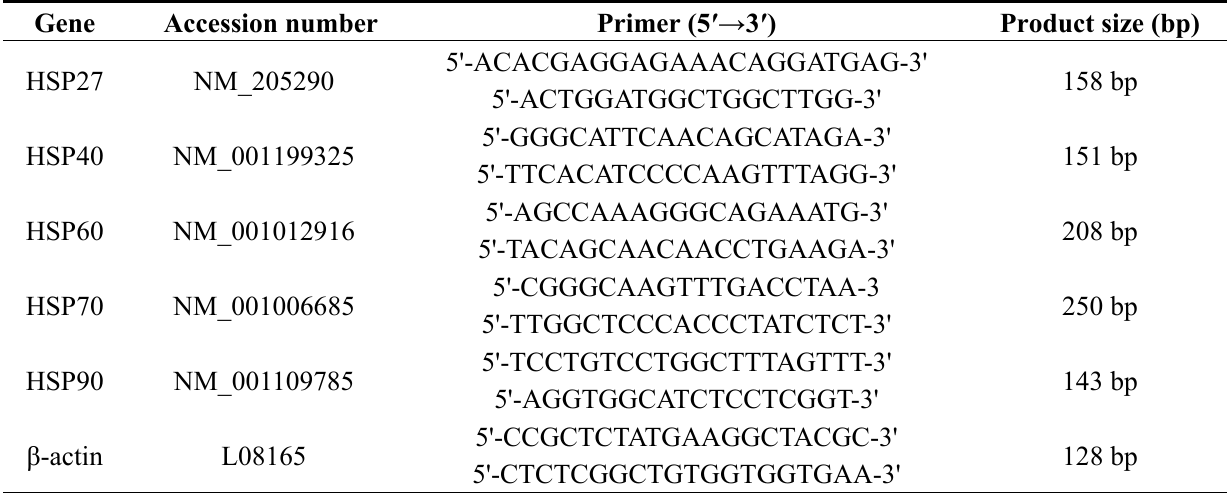
Table 1. Gene-special primers for HSP27, HSP40, HSP60, HSP70, HSP90 and β -actin used in the real-time quantitative reverse transcription